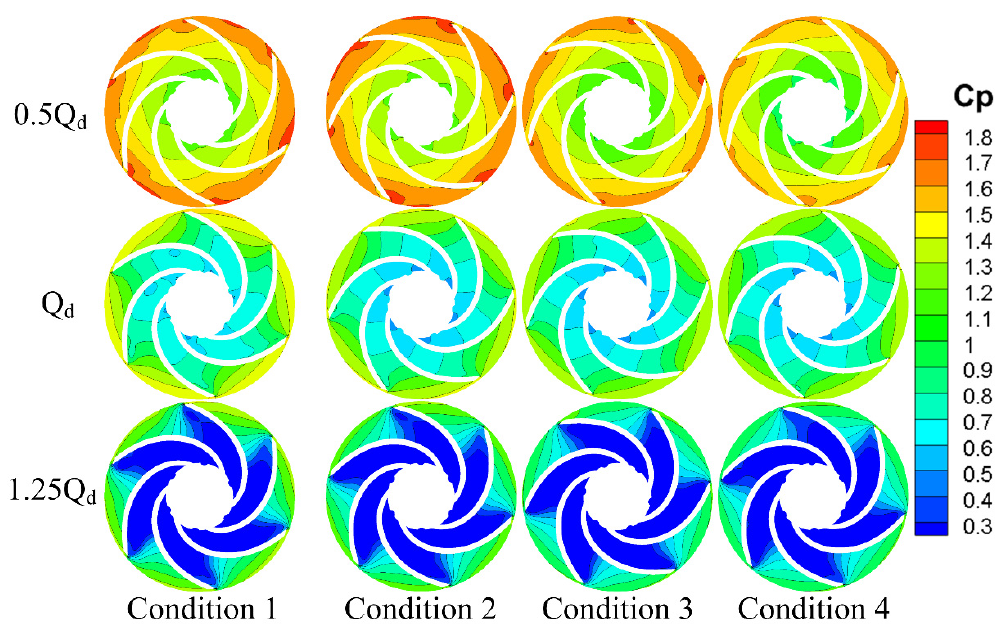
Figure 12 . Impeller channel’s radial section static pressure cloud diagram. Figure 12. Impeller channel’s radial section static pressure cloud